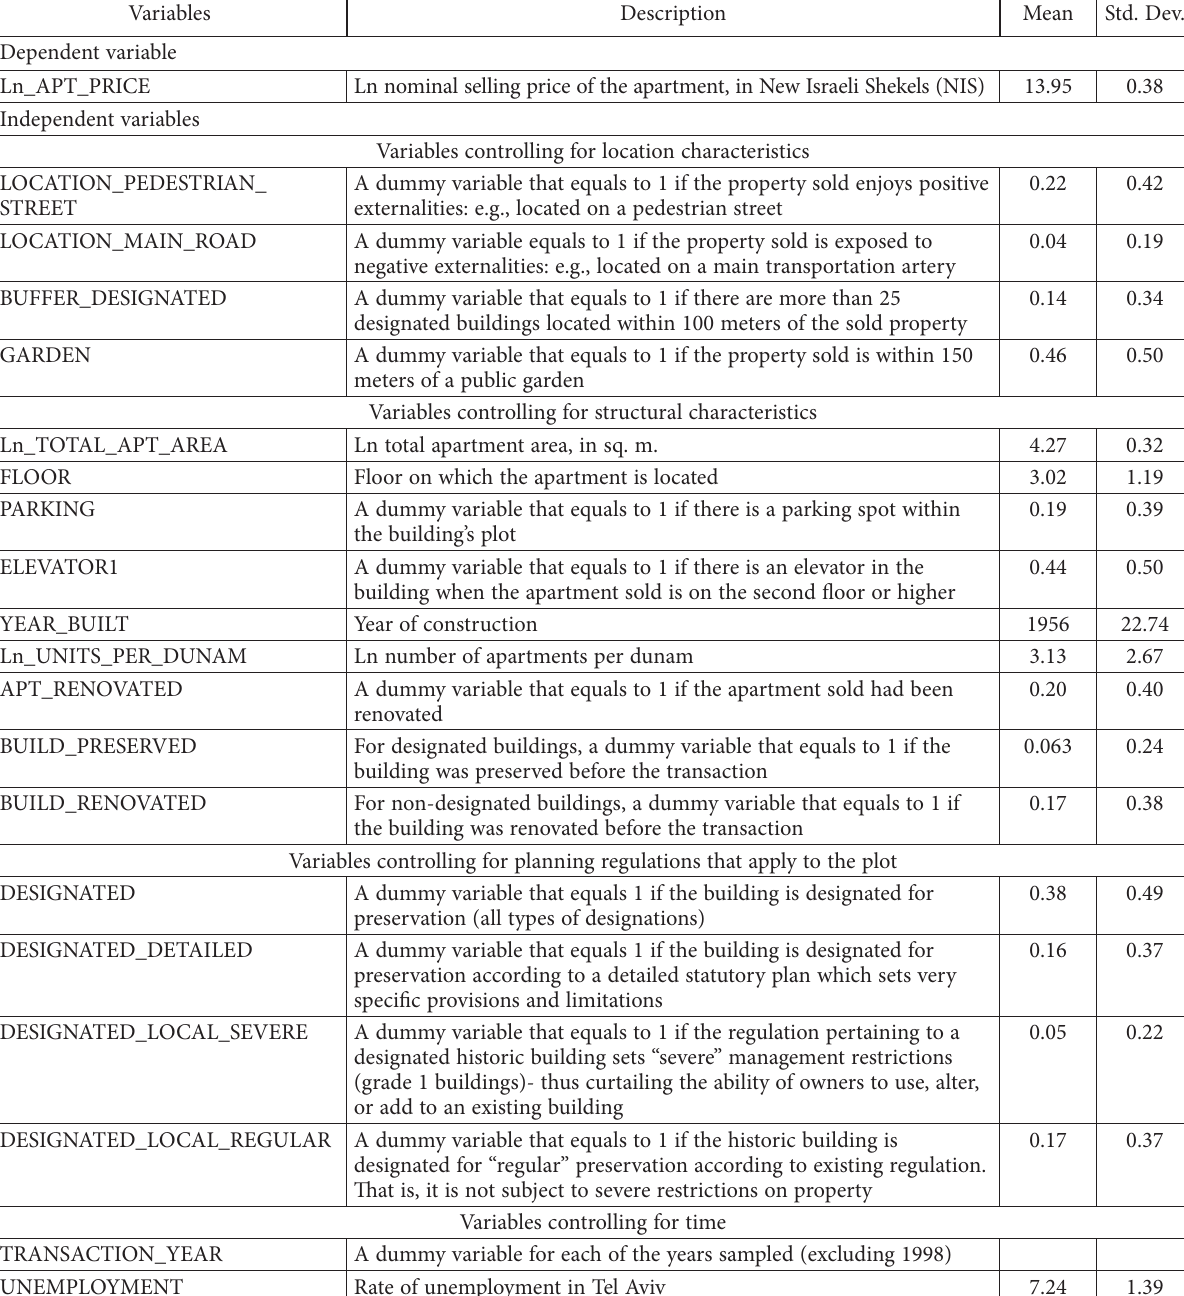
Table 2. Main variables included in the hedonic price method – apartment